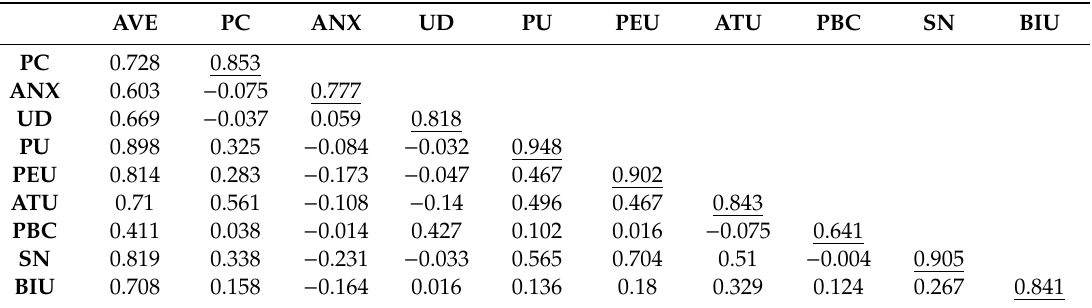
Table 7. Fornell–Larcker Criterion (for RWHS with